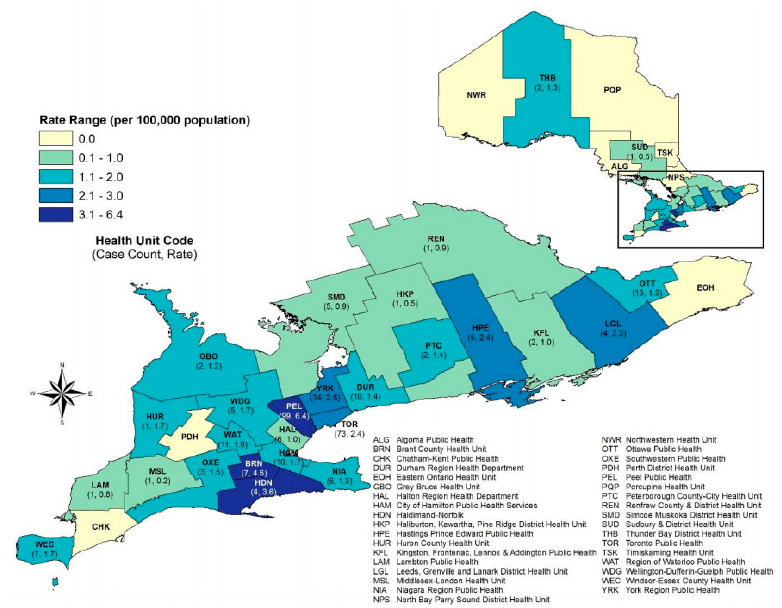
Figure 2. CPE cases and rates by public health unit in Ontario, 1 May 2018 to 30 April 2019 ( n = 315). Adapted from Public Health Ontario [14].